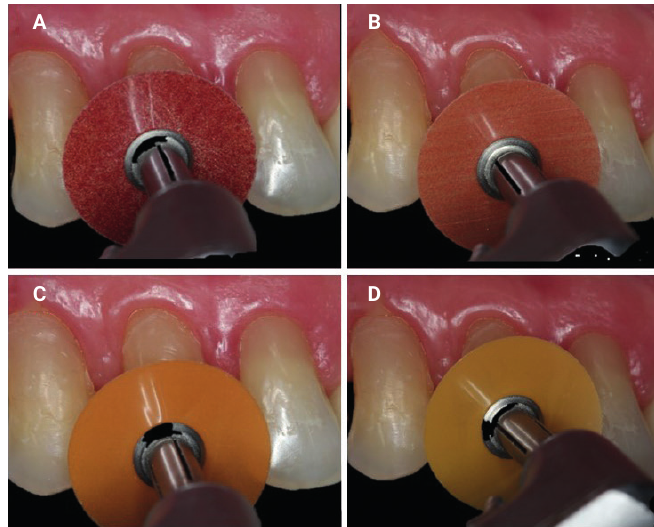
Figure 4. Finishing procedure of restoration. (a, b, c and d) Use of flexible disks with decreasing granulation.